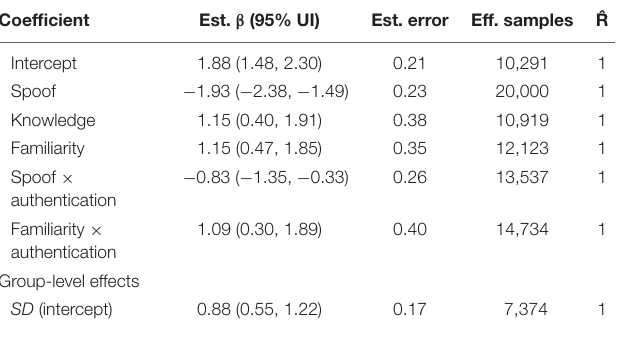
TABLE 3 | Survey-based model coefficients with credible effects different than zero. Coefficient